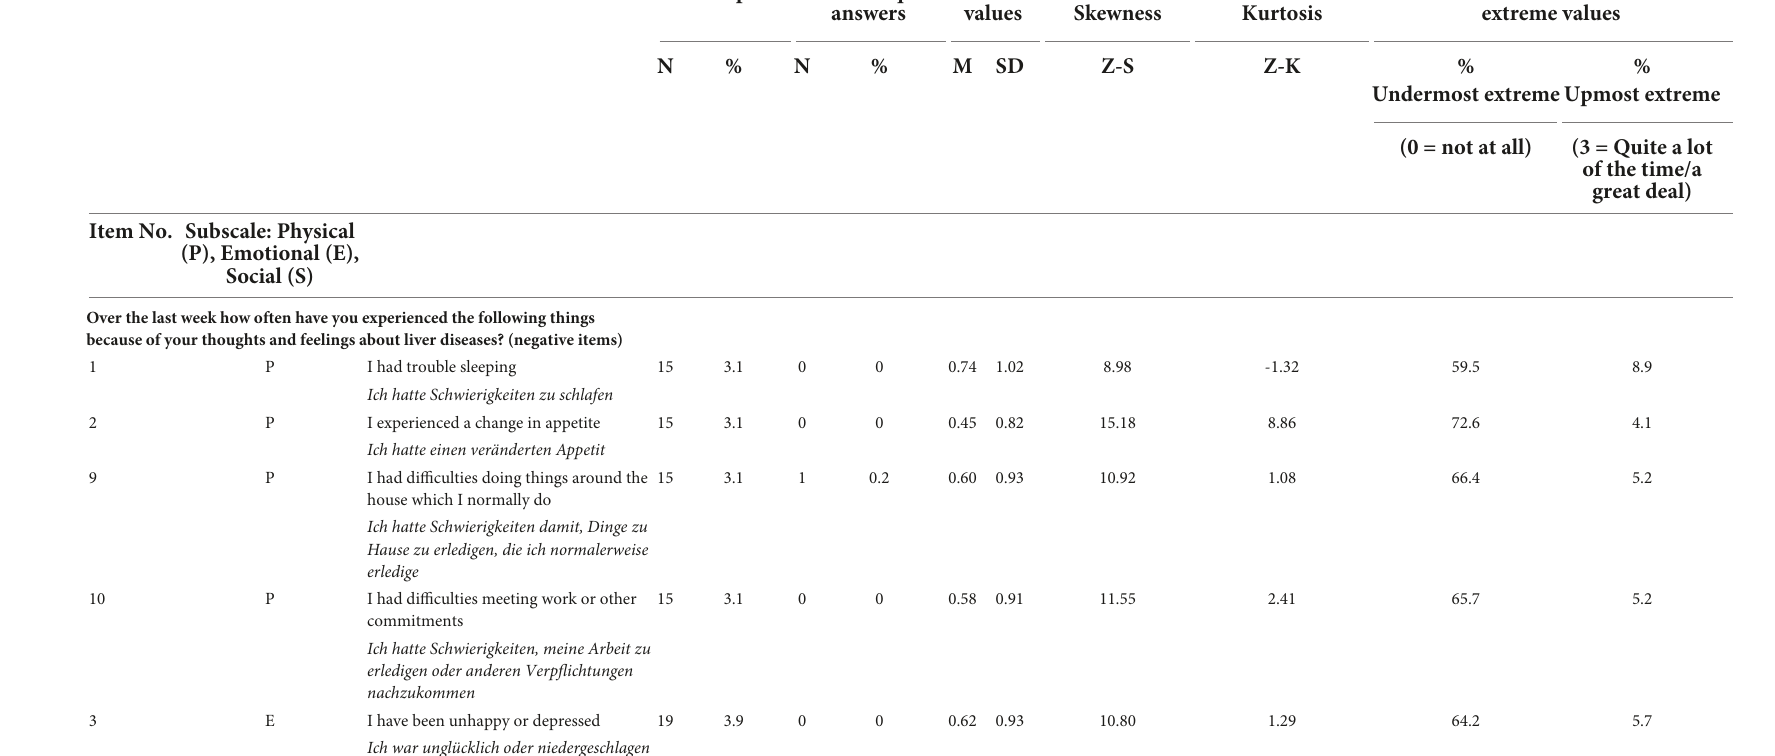
TABLE 1 Distribution parameters: German version of the Psychological Consequences of Screening Questionnaire (PCQ) items.